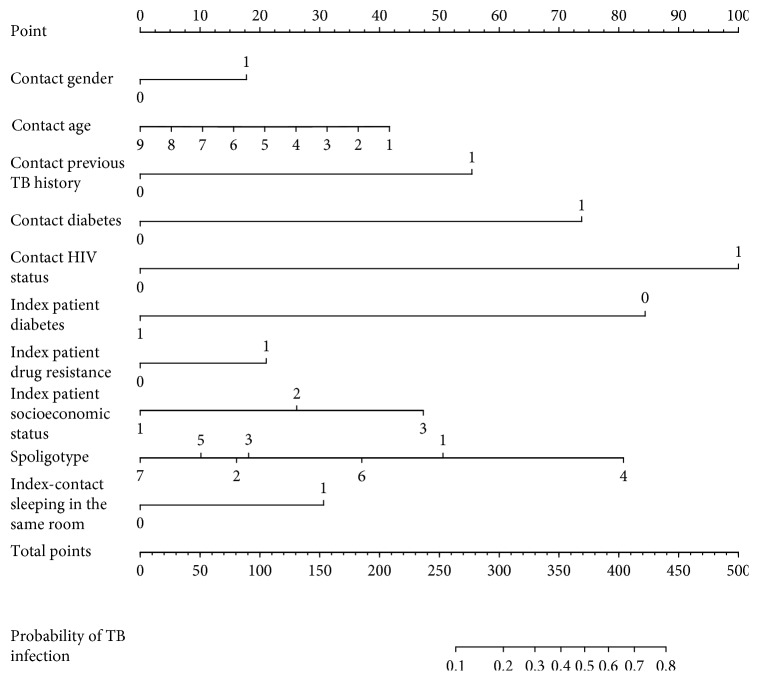
Nomogram for TB transmission in households exposed to TB patients and its algorithm. First, find point for each variable of a contact on the uppermost rule; then add all scores together and find the total point on the “Total points” rule. At last, the corresponding predicted probability of TB could be found on the lowest rule. Codes annotation: contact gender: 0, female; 1, male. Contact age (years): 1, 0 < and ≤ 10; 2 : 10 < and ≤ 20; 3, 20 < and ≤ 30; 4, 30 < and ≤ 40; 5, 40 < and ≤ 50; 6, 50 < and ≤ 60; 7, 60 < and ≤ 70; 8, age > 70; 9, unknown. Contact previous TB history: 0, no; 1, yes. Contact diabetes: 0, no; 1, yes. Contact HIV status: 0, no; 1, yes. Index patient diabetes: 0, no; 1, yes. Index patient drug resistance: 0, no; 1, yes. Index patient socioeconomic status (based on a scoring system used in the Peruvian National Census) [3]: 1, lower tertile; 2, middle tertile; 3, upper tertile. Spoligotype: 1, Haarlem; 2, Beijing; 3, Latin American Mediterranean; 4, T strain; 5, other Euro-American strains; 6, orphan or no family; 7, unknown. Index-contact sleeping in the same room: 0, no; 1, yes.